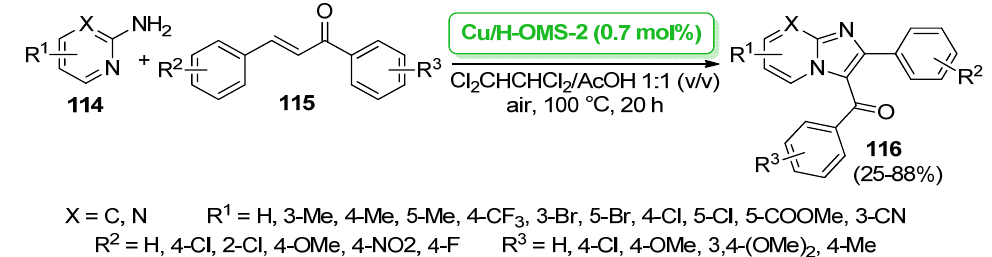
Scheme 33. Synthesis of 3-aroylimidazo[1,2- a ]pyri(mi)dines 116 by tandem Michael addition/oxidative cyclization of 2-aminopyri(mi)dines 114 with chalcones 115 catalyzed by Cu/H-OMS-2, reported in 2016 by Zhao and co-workers